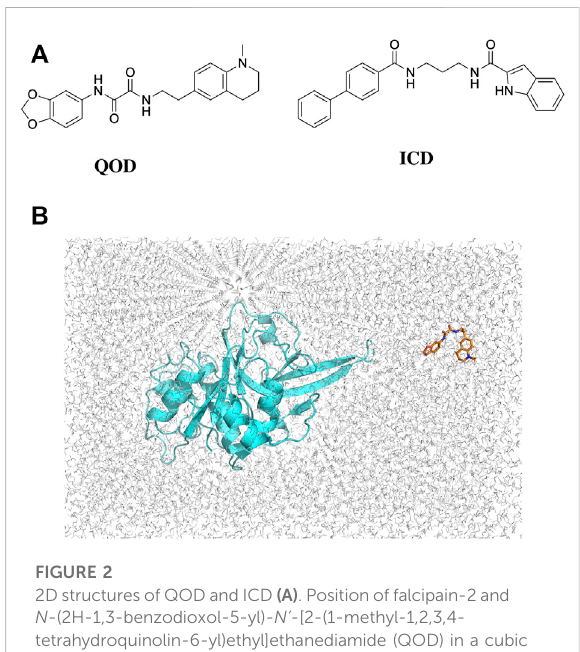
FIGURE 2 2D structures ofQOD and ICD (A) . Position offalcipain-2 and N -(2H-1,3-benzodioxol-5-yl)- N ’ -[2-(1-methyl-1,2,3,4- tetrahydroquinolin-6-yl)ethyl]ethanediamide (QOD) in a cubic simulation box (B)